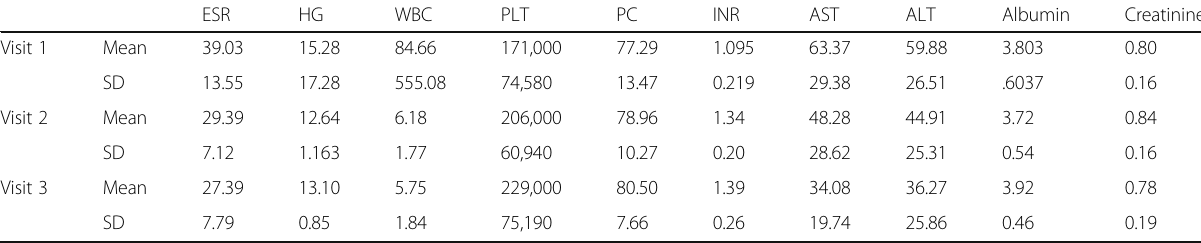
Table 6 Comparison of various laboratory indices between follow-up visits ( mean ± SD)